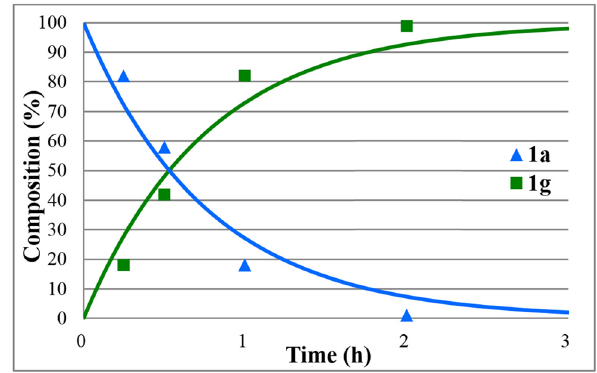
Figure 11: Concentration pro fi le for the components ( 1a and 1g ) during the alcoholysis of methyl diphenylphosphinate ( 1a ) with pentanol under MW condition at 220°C, in the presence of 10% of [ bmim ][ PF ] monitored by LC - MS. The R 2 measure of goodness of fi t 6 is 0.938 ( k = 1.31 h − 1 ) .